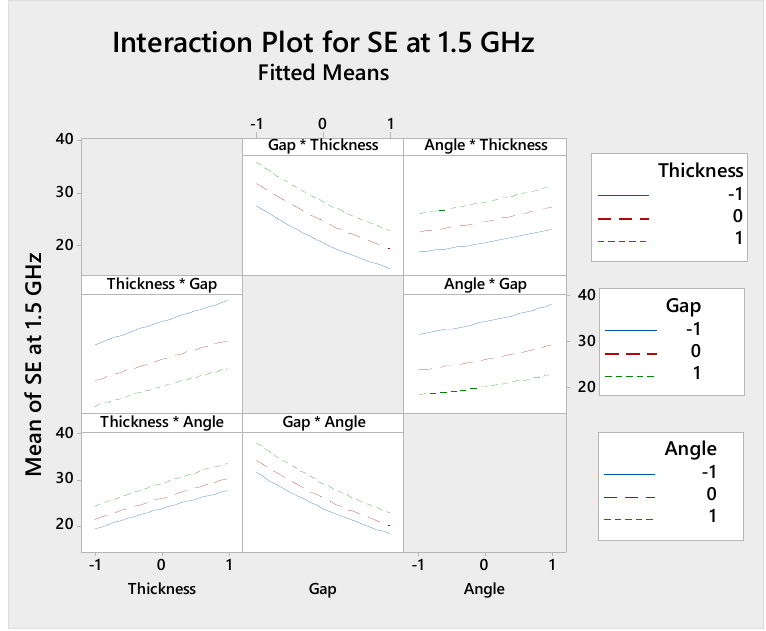
Figure 10. Interaction plot for SE (dB) at 1.5 GHz for the combination of two factors.